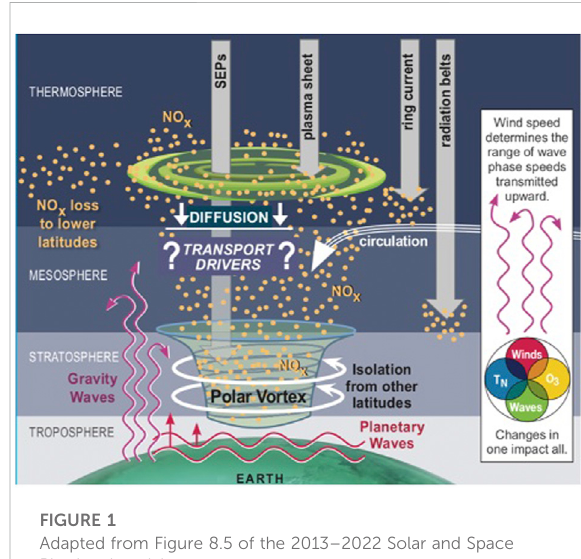
FIGURE 1 Adapted from Figure 8.5 of the 2013 – 2022 Solar and Space Physics decadal